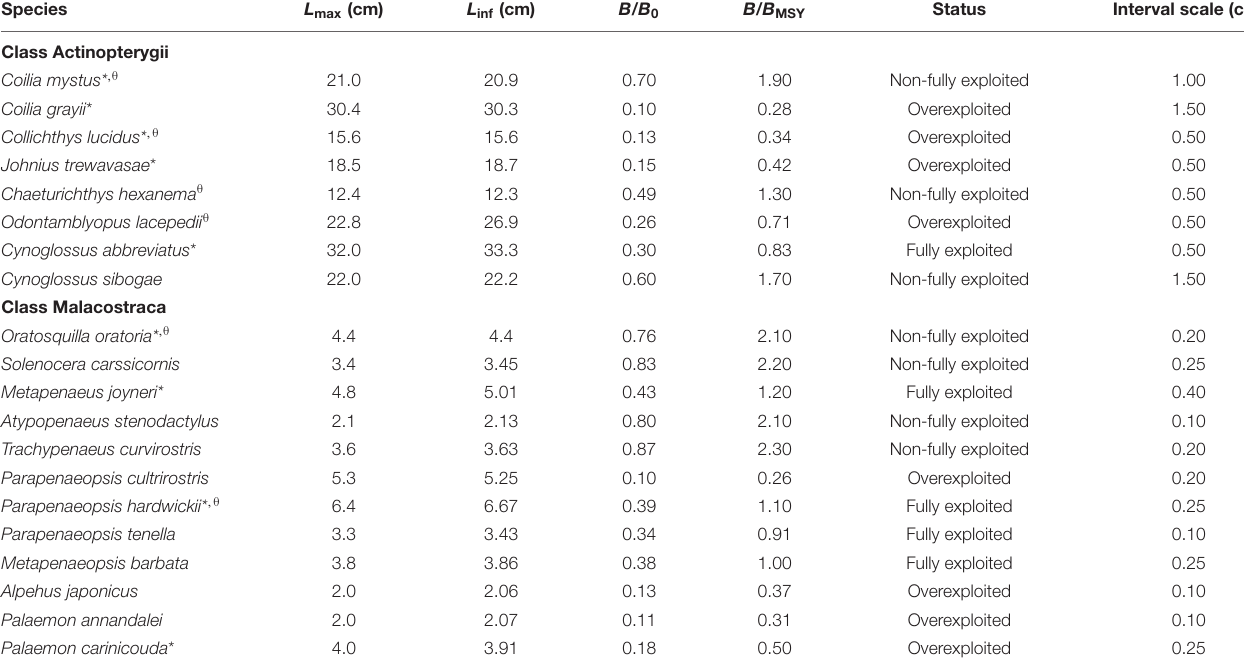
TABLE 2 | Fishery statuses of the 20 species assessed in the Min River Estuary and its adjacent waters, Fujian Province, southern China. Species L max (cm) L inf (cm) B/B 0 B/B